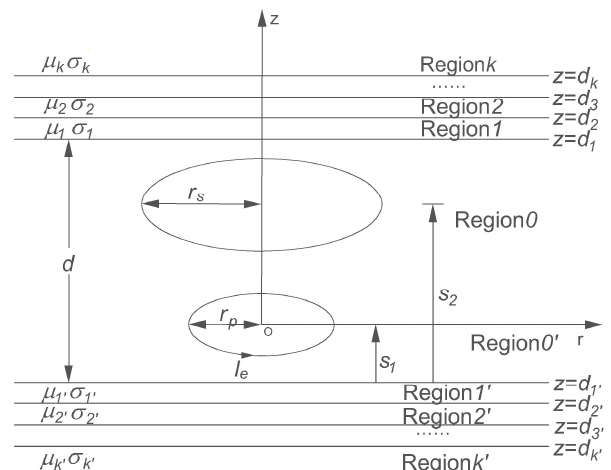
Figure 2. Schematic of the filamentary circular single-turn coil with two multilayer media.